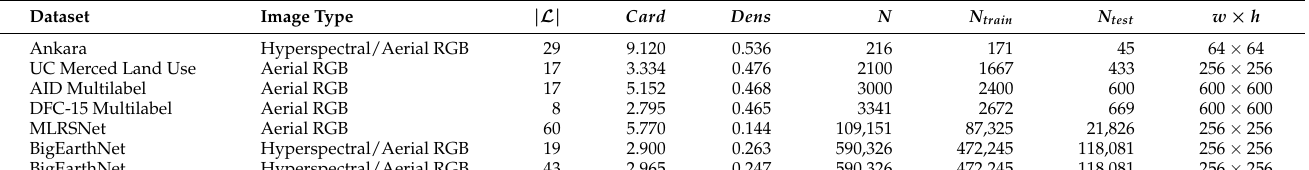
Table 1. Description of the used RSI multi-label datasets. |L| denotes the number of possible labels; Card denotes label cardinality (i.e., average number of labels per image); Dens denotes label density (average proportion of images labeled with a given label); N is the number of images in the dataset, of which N train are in the train and N test in the test datasets; and w × h is the dimension of the images (in pixels).